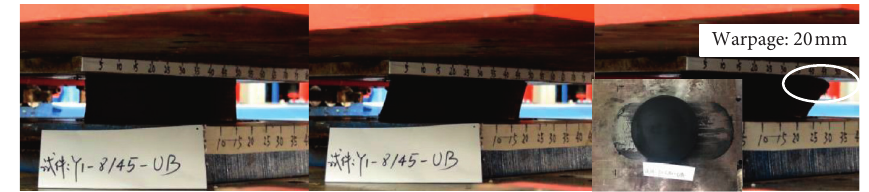
Figure 5: Bearing response in different stages.